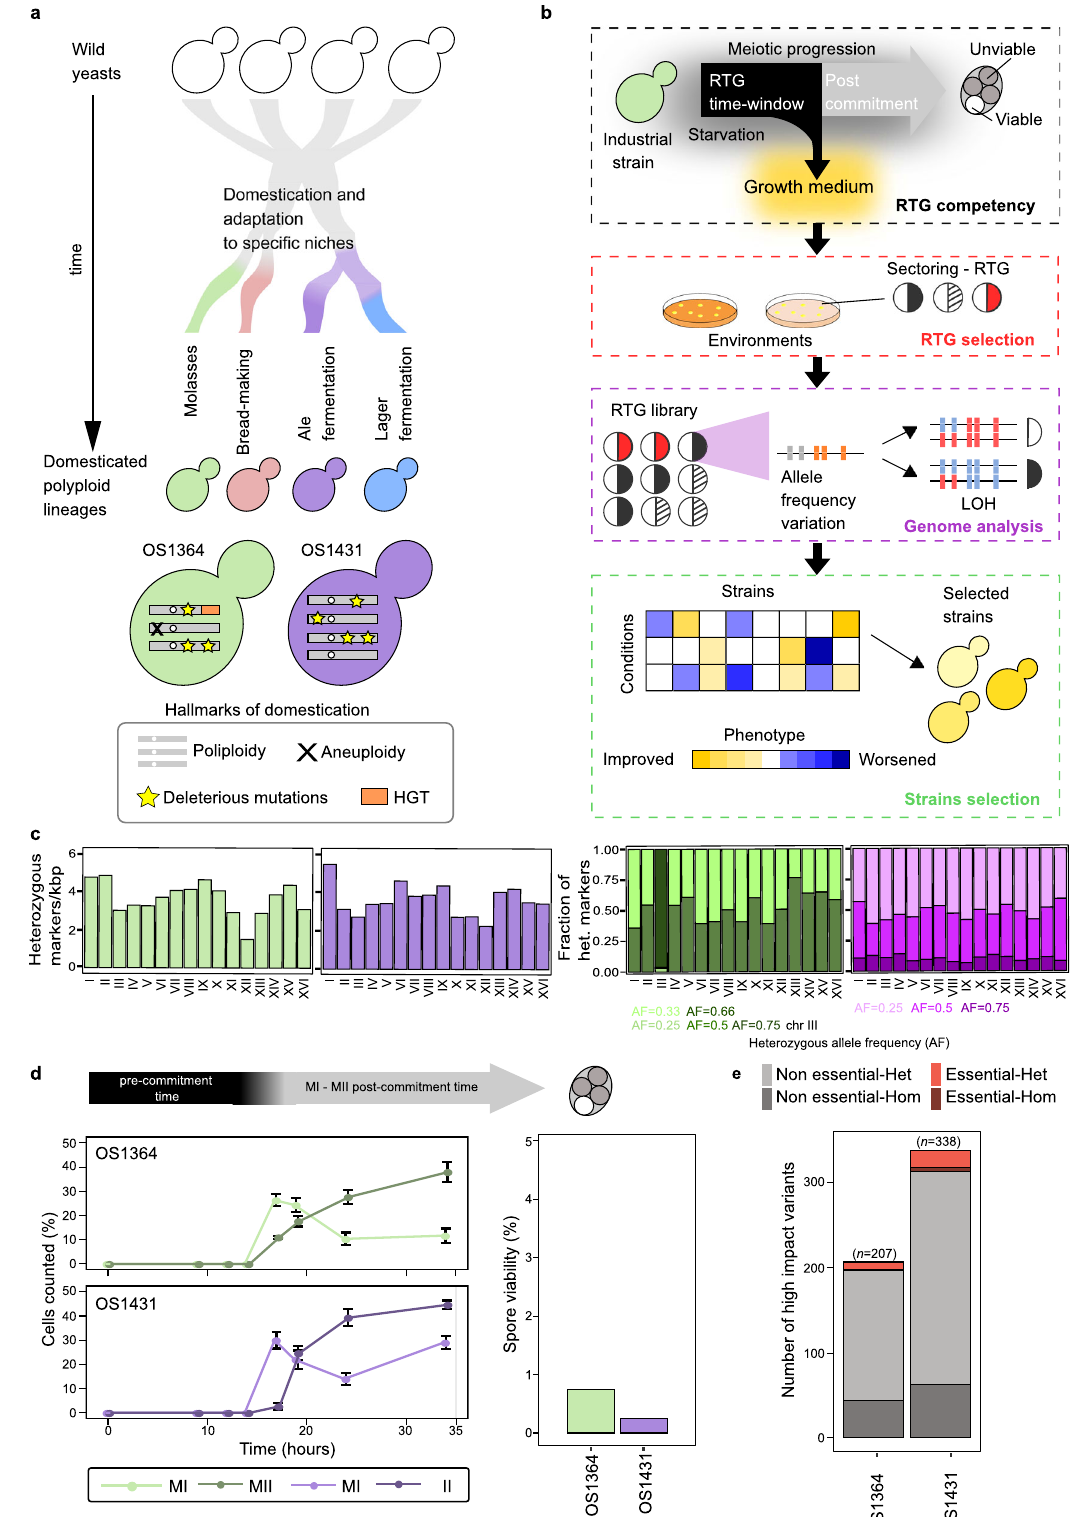
bailii (Supplementary Figure 1e). This HGT region has been previously described in wine strains and is known to harbour genes that improve fi tness in the fermentation environment 26 . The genetic diversity observed in the two strains re fl ect the dif- ferent evolutionary histories of their haplotypes before or after the